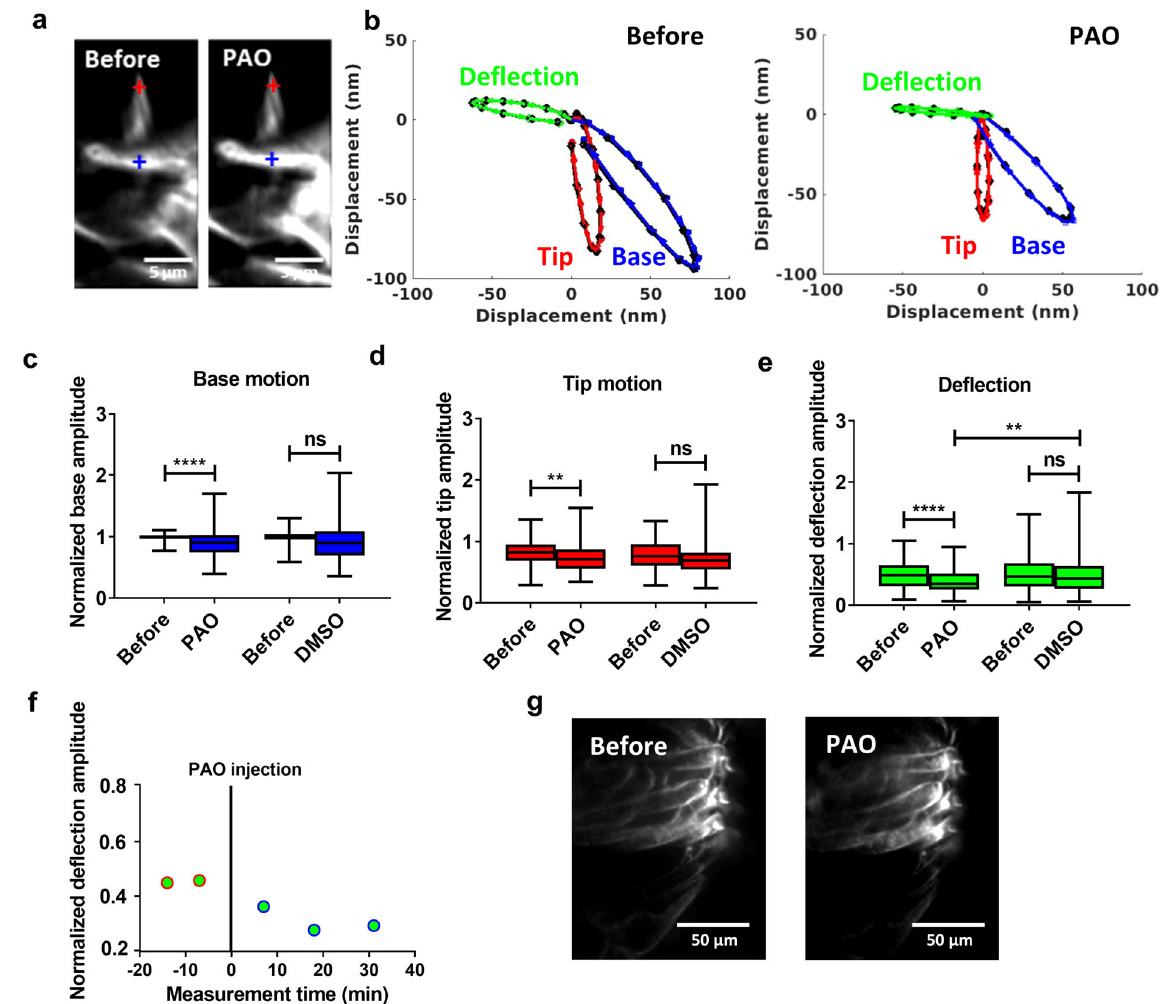
Fig. 6 PAO-induced effects on OHC stereocilia sound-evoked motions. a Time-resolved confocal image of an OHC stereocilia bundle showing the morphology is intact before and after the injection, except for a small change in the brightness of the fl uorescent dye. b Representative data showing change in sound-evoked motion of the bundle tip (red) and base (blue) before and after PAO injection. The stimulus was a pure tone at 220Hz and 80 dB sound pressure level. c – e Averaged change of the bundle motion at the base of outer hair cell stereocilia (blue bar), at their tip (red bar), and de fl ection (green bar) are shown. Signi fi cant decrease in tip and base motion resulting in a change in the bundle de fl ection. Data were normalized to the base trajectory amplitude recorded before the injection. Mean data from 35 (PAO) individual preparations ± s.d. f Example time course of de fl ection amplitude of outer hair cell stereocilia bundle (blue circle) showing decrease after PAO injection. The vertical line at time zero indicates the time of injection of PAO. Data were normalized to the average trajectory amplitude recorded before injection. g High-resolution confocal images of stereocilia in preparations treated with PAO or vehicle show no detectable morphological difference. **** P < 0.0001; ** P < 0.01; * P < 0.05; n.s., not signi fi cant; two-tailed paired t